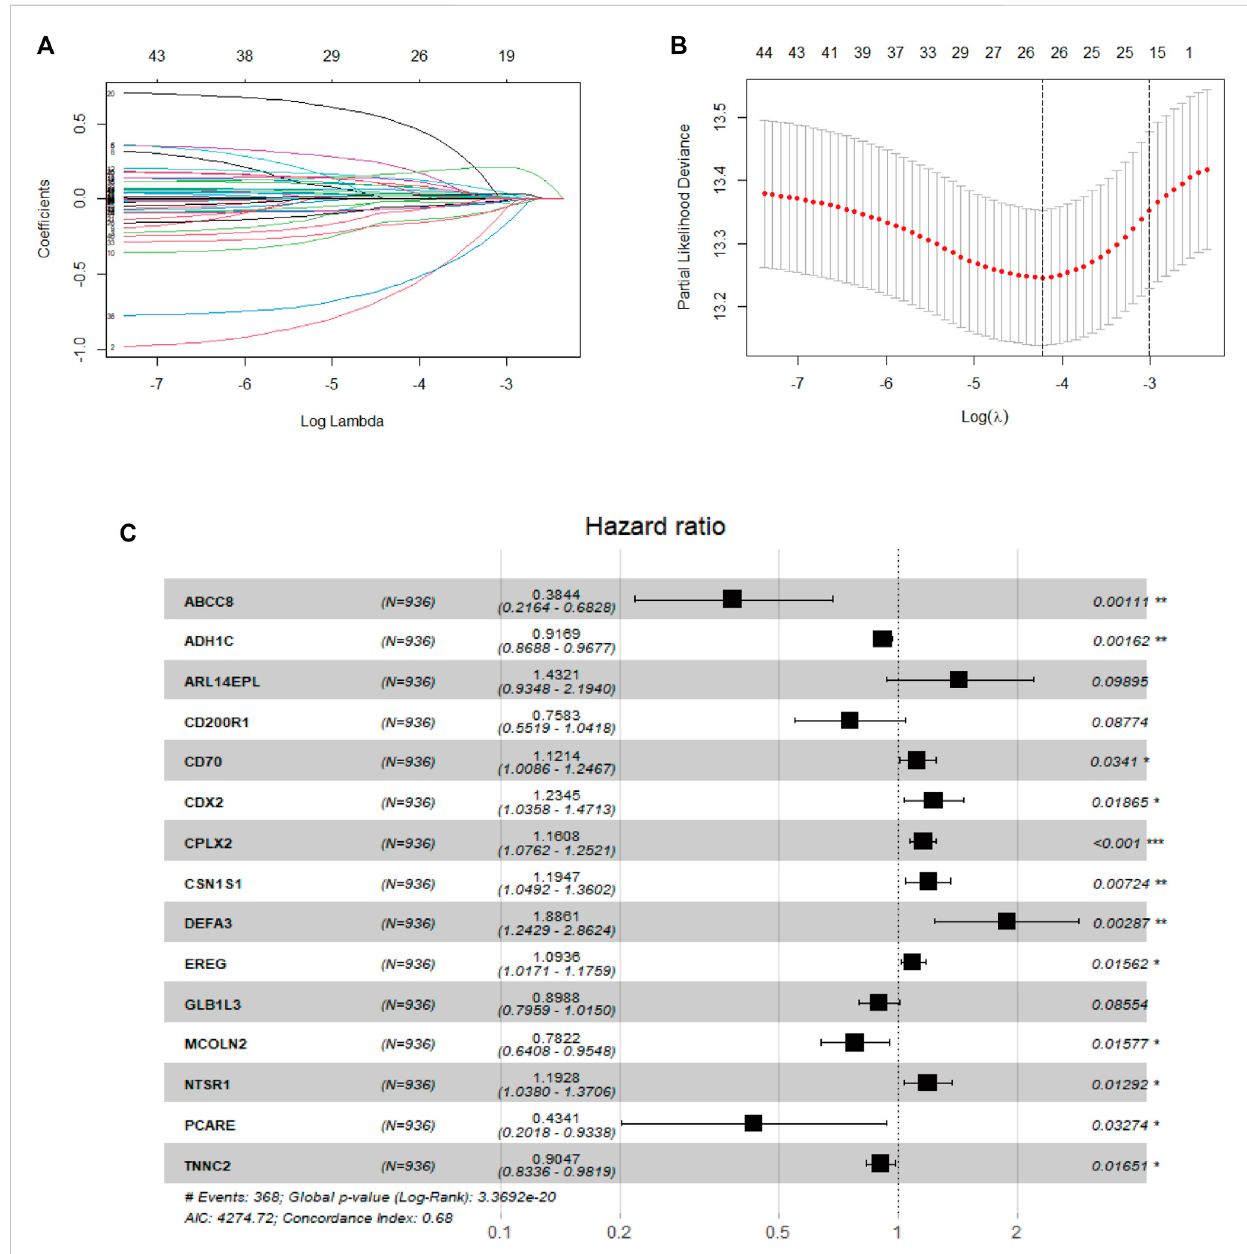
FIGURE 4 Development of the prognostic signature in the TCGA cohort (A) . Diagnostic model construction using a LASSO regression model (B) . Coef fi cient distribution plots to select the optimum lambda value (C) . Results of multivariate Cox regression analysis of OS in the TCGA